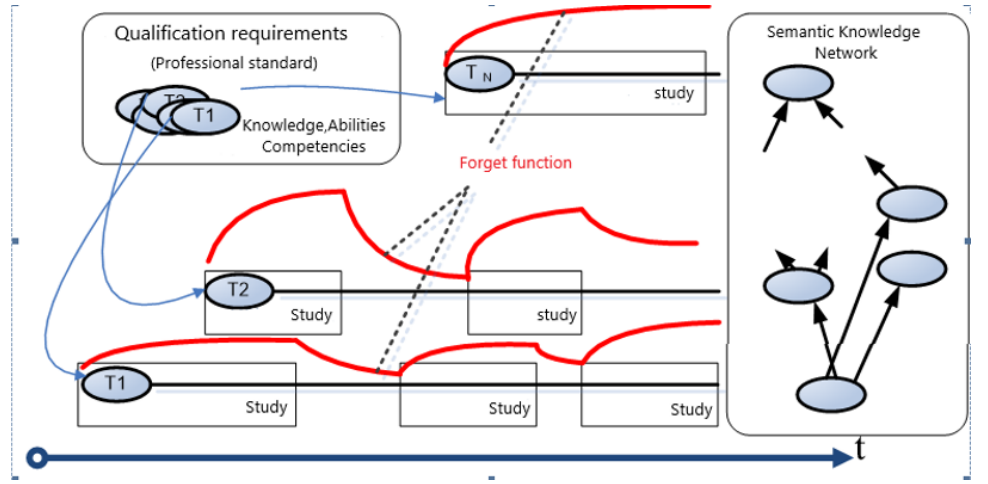
Fig. 7. The construction of learning-forgetting functions UZ(t) terms of the